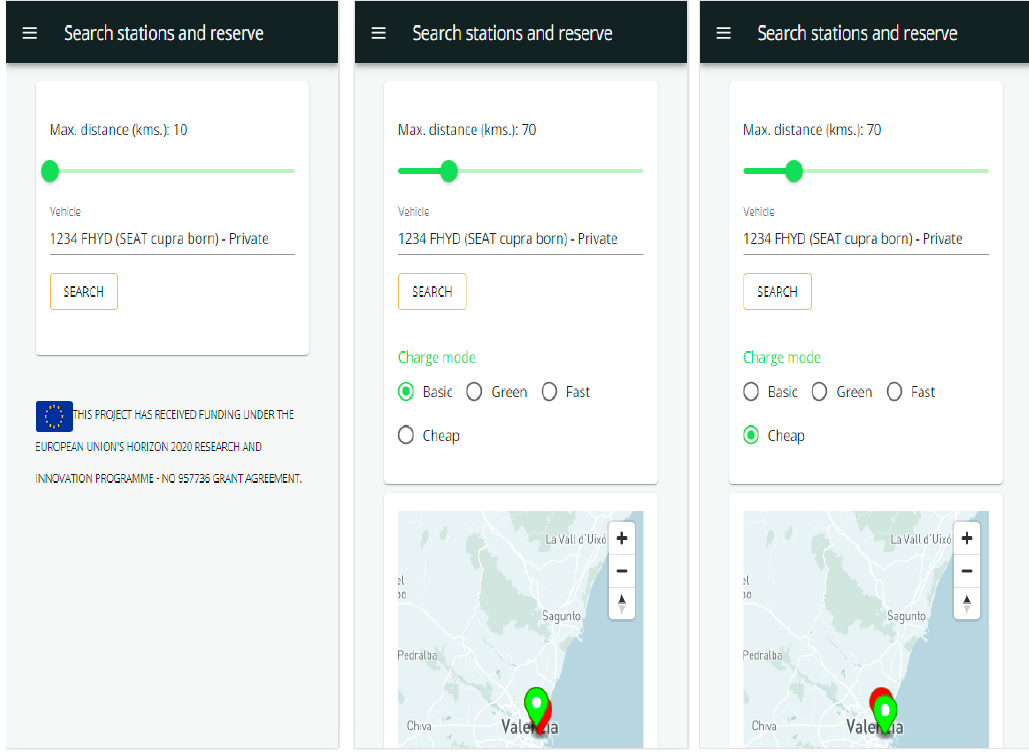
Figure 4. Search stations and reserve screen. Search operations and Reservation of charge point.